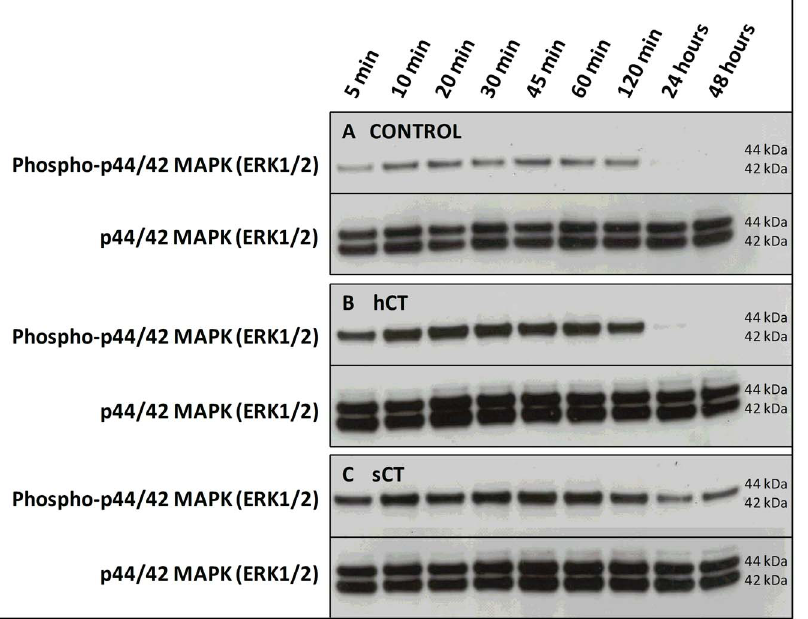
Figure 4. Prolonged ERK activation/phosphorylation in Cos-7 CT (a) R cells by sCT, but not hCT. Cos-7 CT (a) R Cells were stimulated for 5 min, 10 min, 30 min, 120 min, 24 hours or 48 hours with either Vehicle (A), 100 nM hCT (B) or 100 nM sCT (C). At each time point, the cells were lysed and protein content extracted. The protein extracts was then analyzed by western blotting investigating ligand-mediated phospho-ERK1/2 activation. Total ERK1/2 was used as a protein loading control.